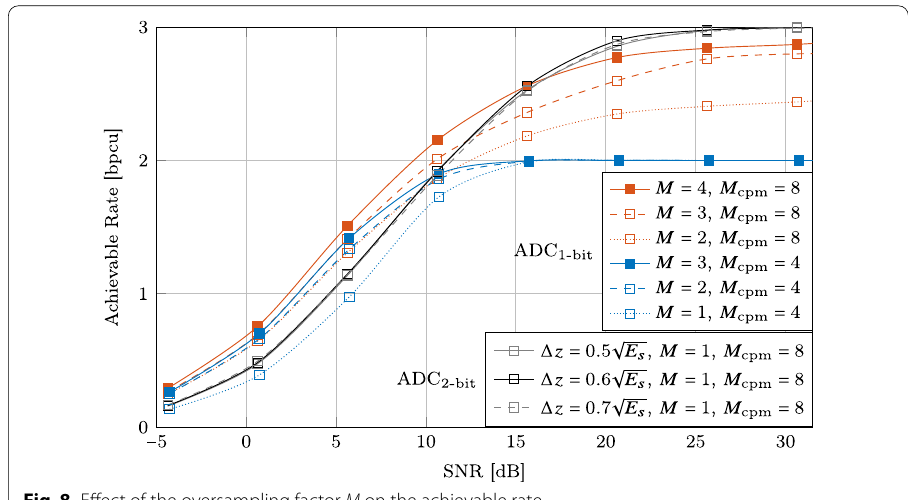
Fig. 8 Effect of the oversampling factor M on the achievable